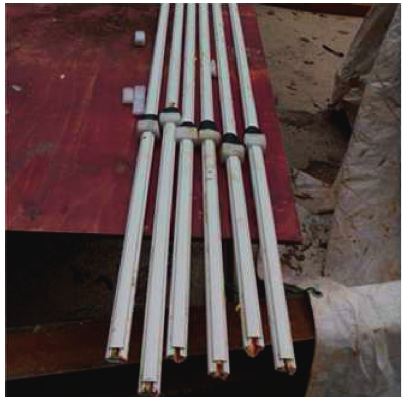
Figure 20: Shaped charge device after